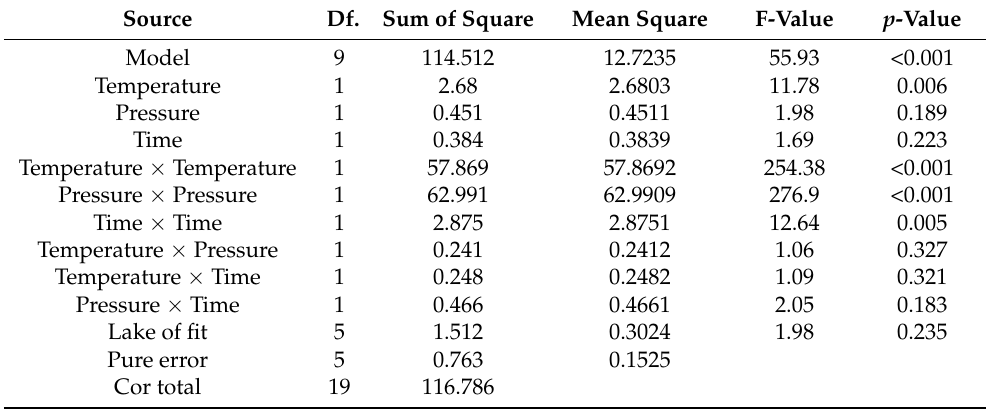
Table 6. Analysis of estimated regression coefficients for the CCD model